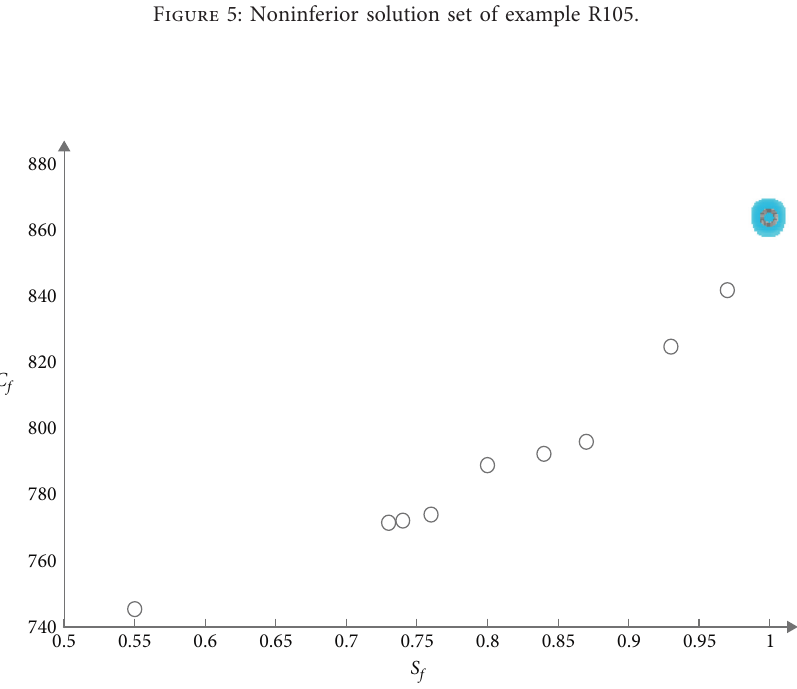
Figure 6: Noninferior solution set of example